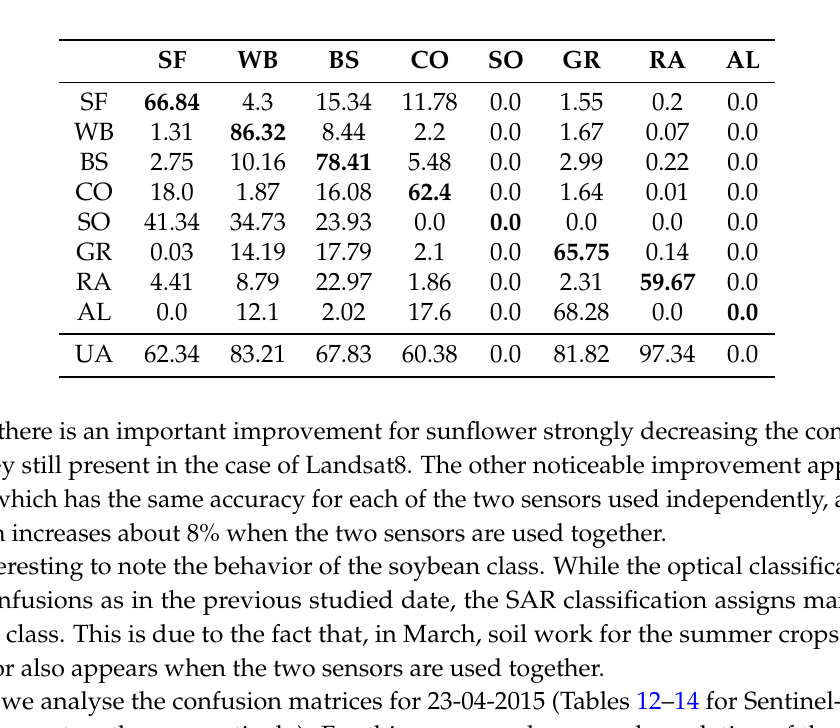
Table 11. Confusion matrix for 24-03-2015 using Sentinel-1 (5 images) and Landsat8 (7 images). κ =